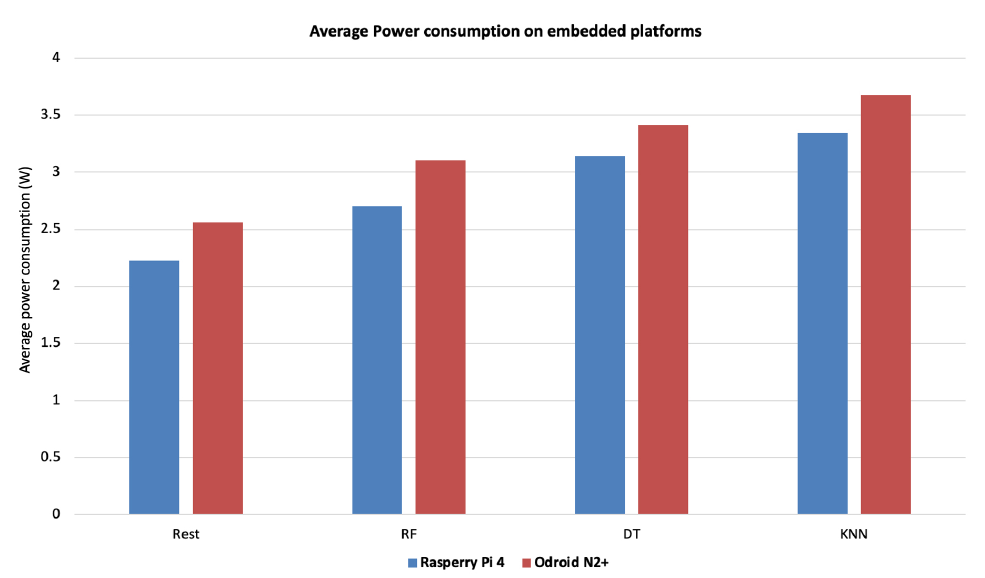
Figure 5. Average power consumption (W) of rest phase and of each classifiers on the embedded boards.